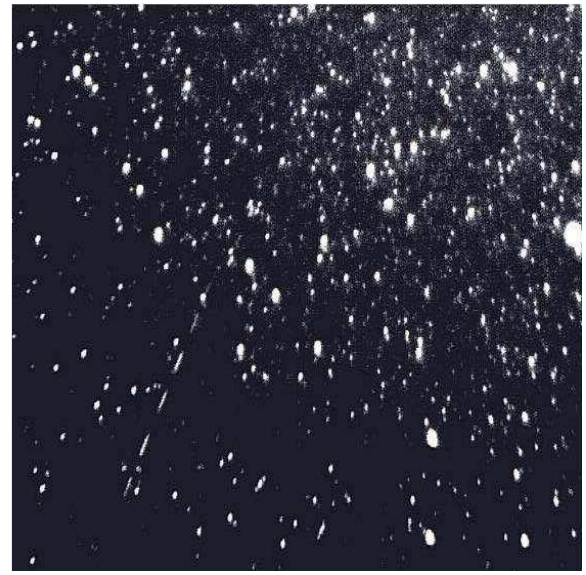
Fig. 2 Summarized meteor frame Date: 2006-08-31-00h41m28s From Space Debris average brightness 5.5m,elongation 86 ◦ ,angular speed 2.1 deg/sec,linear speed 3.4